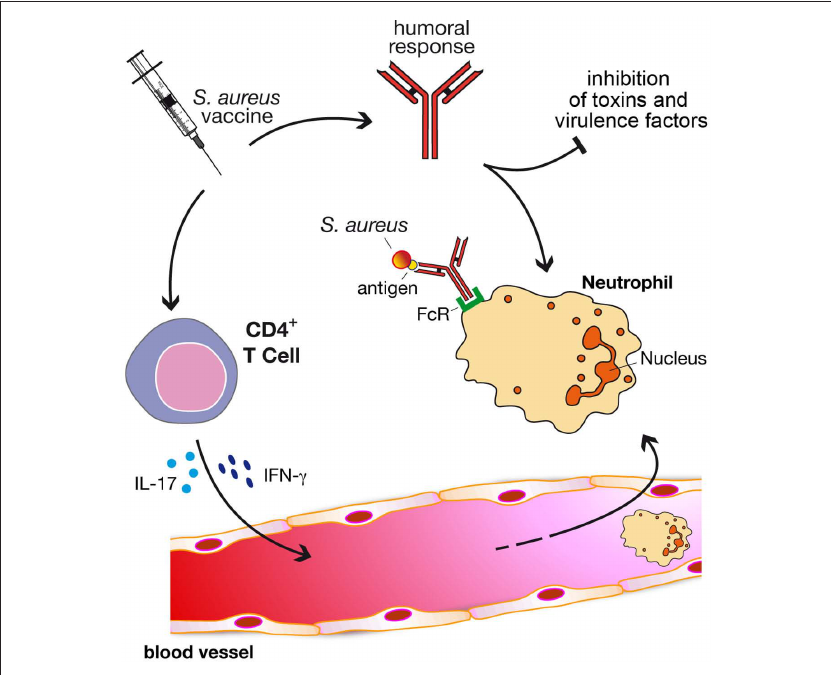
FIgure 1 | A model to generate protective immunity against S. aureus infections through vaccination. Protective vaccines should be able to elicit three major immune responses: (i) antibodies to directly inhibit bacterial viability and/or toxicity; (ii) antibodies to mediate opsonophagocytosis; and (iii) cell-mediated immunity to stimulate recruitment of phagocytes (e.g., neutrophils) at the site of